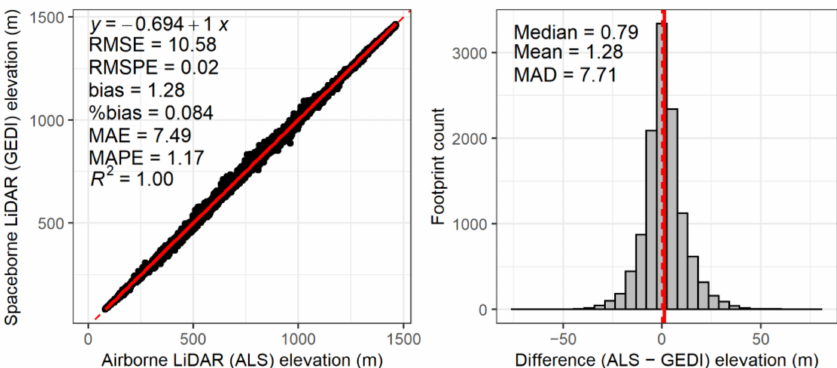
Figure 3. Comparison of ALS derived ground elevation compared to GEDI, for all individual footprints (11,832). ( left ) Scatter plot of ALS and GEDI elevation values (meters). The 1:1 line is shown (dashed), along with the linear regression (solid red line). ( right ) Histogram showing the distribution of the difference between the elevation values (ALS, GEDI).